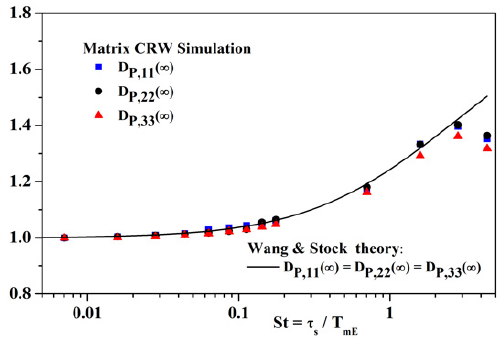
Figure 21. Normalized variance of particle velocity (g = 0).